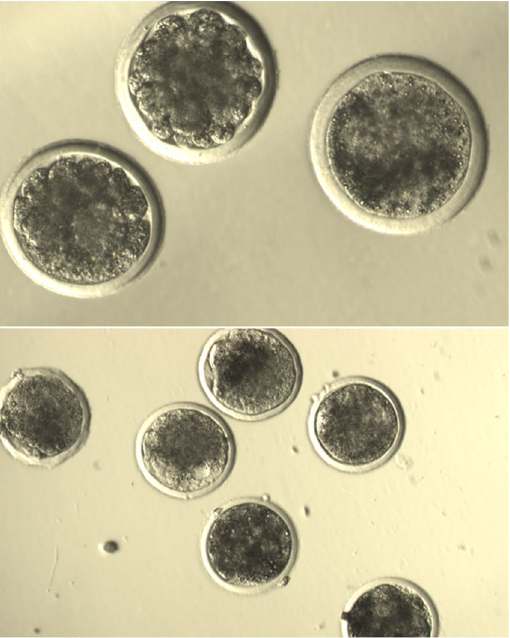
Figure 4. Ovine embryos developed from oocytes 168 h after injection with freeze-dried